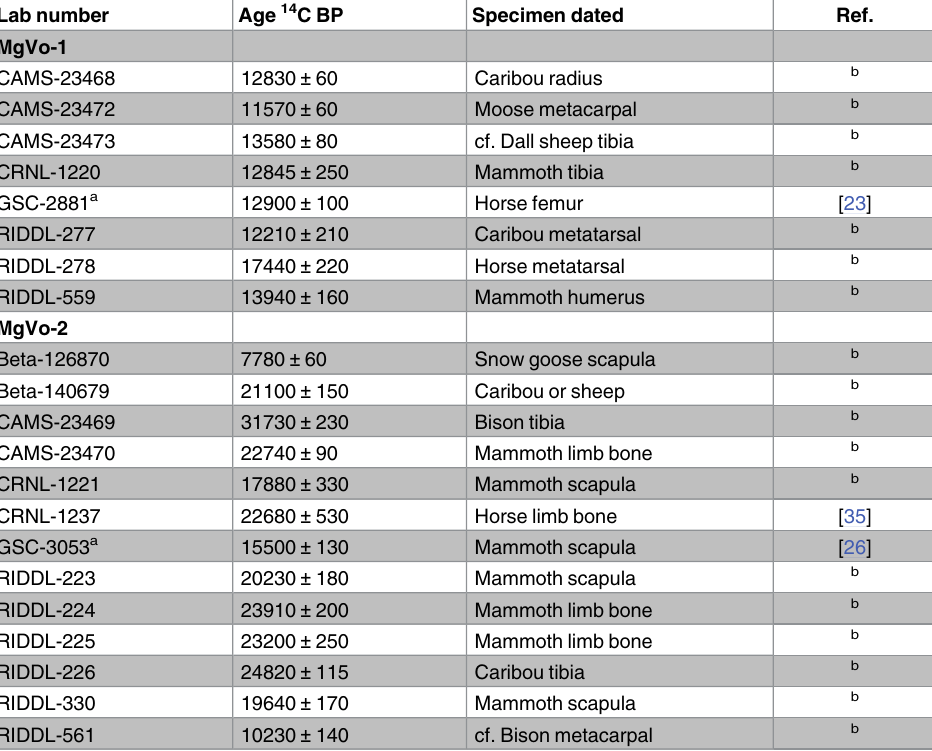
Table 1. Previous radiocarbon dates obtained on bone from Bluefish CavesI (MgVo-1) and II (MgVo-